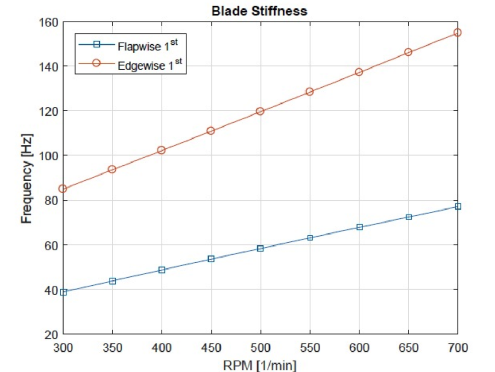
Figure 6. Simulation of the first resonant frequency of the blades as a function of the rotational